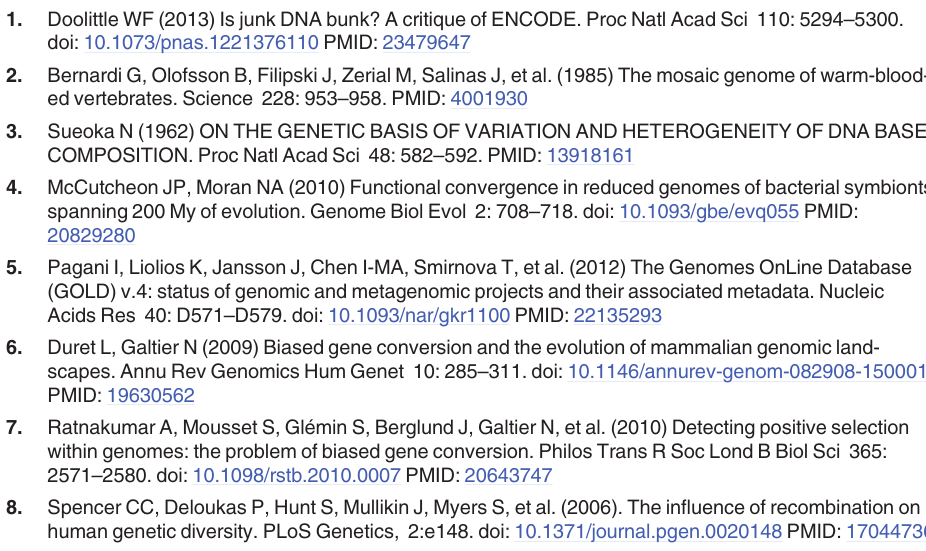
S3 Fig. Comparison of several recombination detection programs on the inferred effect of recombination on codon usage of core genes, based on RP optimal codons. Legend as in Fig. 2. S4 Fig. Comparison of several recombination detection programs on the inferred effect of recombination on codon usage of core genes, based on HCB optimal codons from Hershberg and Petrov (2009). Legend as in Fig. 2. S1 Table. Detailed results of statistical tests of difference of GC% and Fop/Fnop between re- combining and nonrecombining core genes, varying recombination detection methods and tested alignment length. S2 Table. Sets of optimal/non-optimal codons defined using RP method. S3 Table. Sets of optimal/non-optimal codons defined using HCB method. Data derived from dataset established by Hershberg and